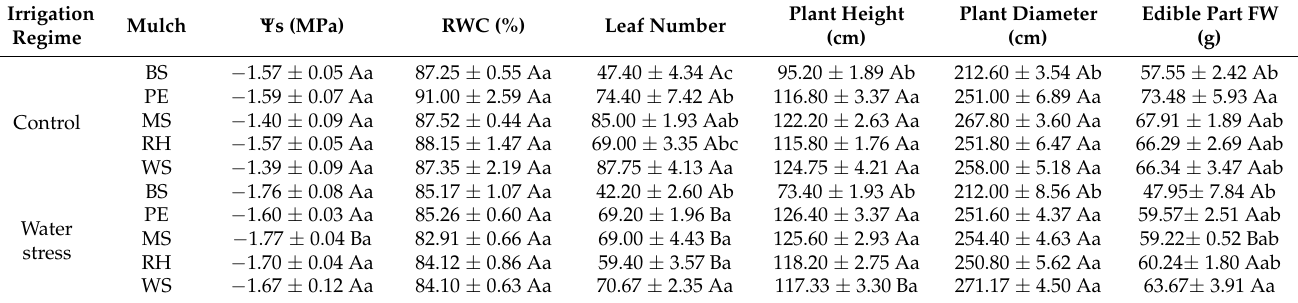
Table 1. Osmotic potential ( Ψ s), relative water content (RWC), and the growth-related parameters, number of leaves, plant height, plant diameter, and fresh weight (FW) of edible part measured in artichoke plants (cv. Symphony) cultivated under different mulching and irrigation